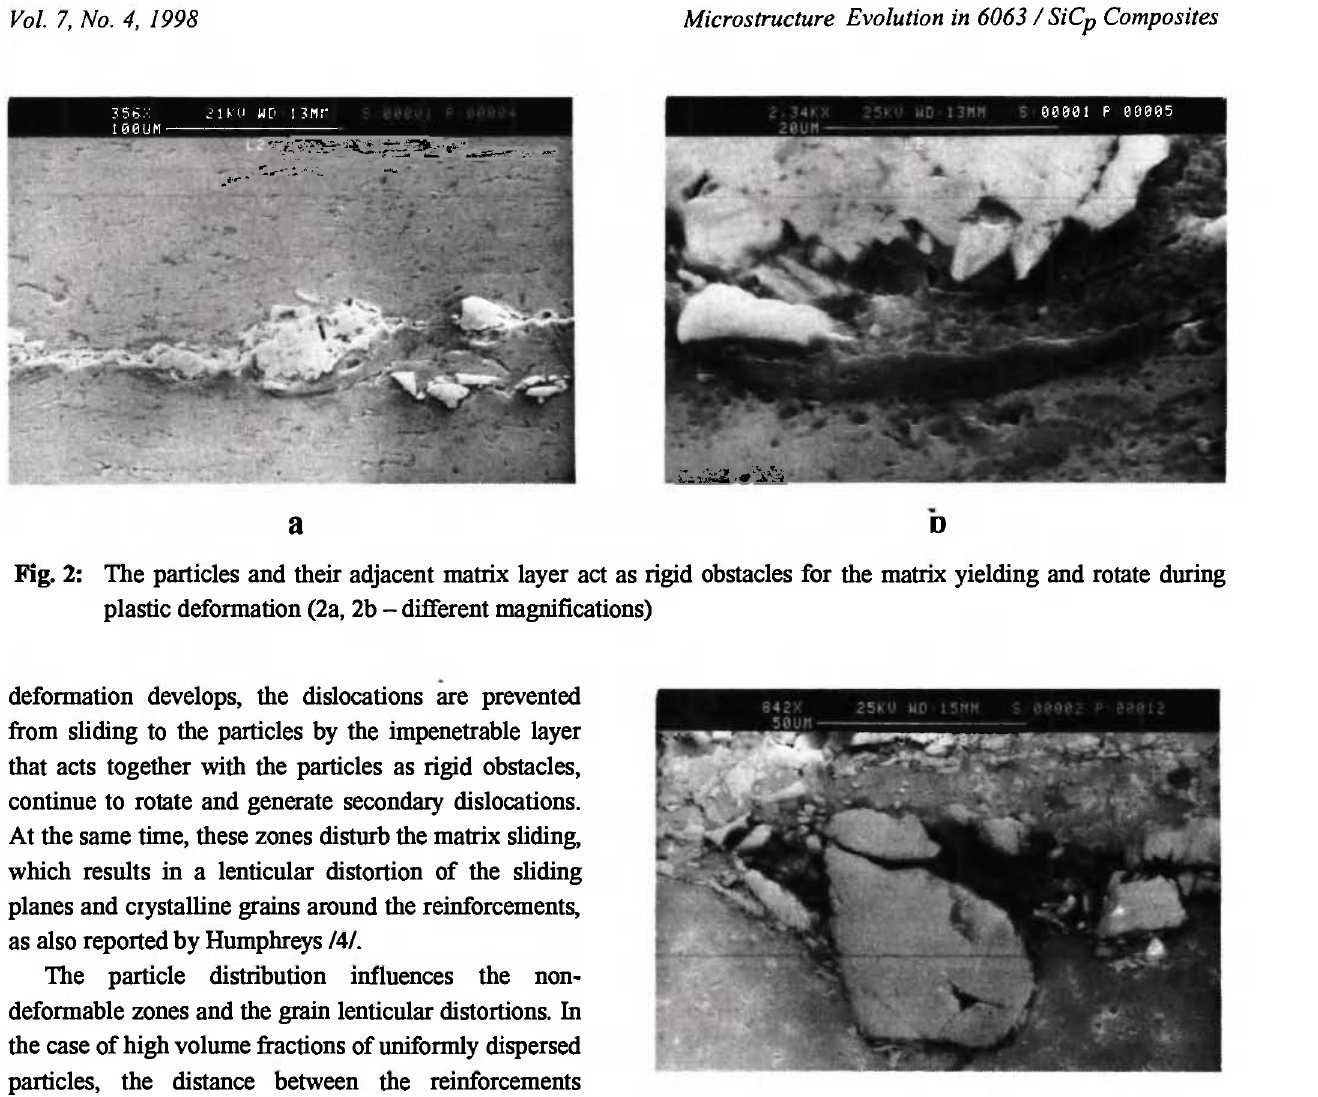
Fig. 3: Particle fracture followed by interface decohesion during rolling with a high degree of